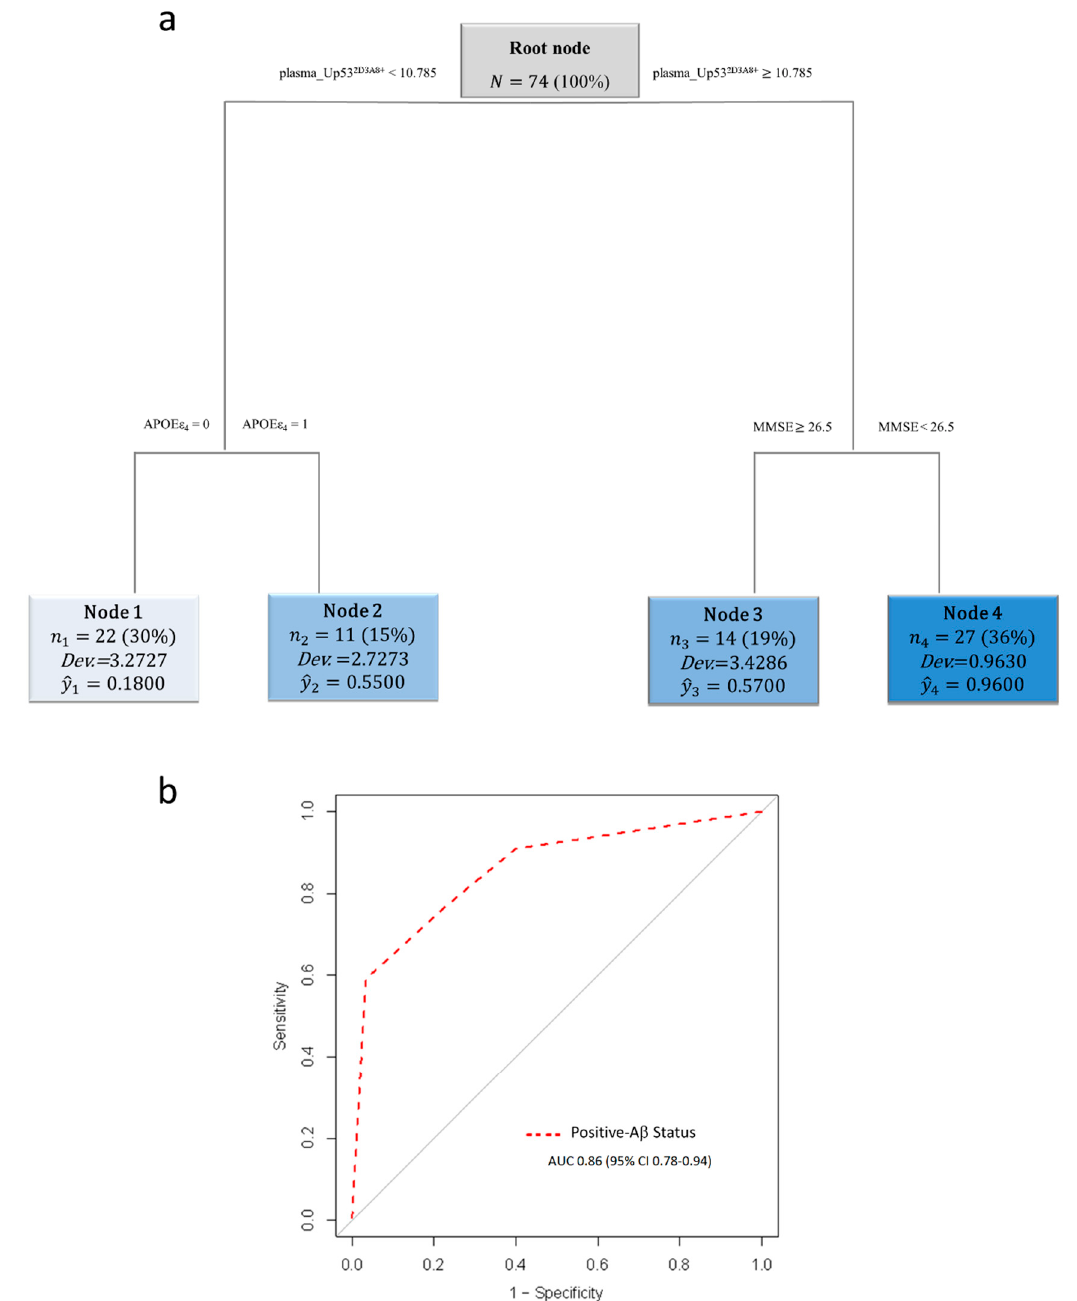
Figure 5. U-p53 2D3A8+ plasma-based algorithm classification of A β status in PharmaCog/E-ADNI subjects. Schematic representation of the regression tree algorithm obtained by combining U-p53 2D3A8+ with MMSE and APOE ε 4 to classify A − /T − ( n = 30) and A β + -subjects (A + /T +/ − ) ( n = 44) ( a ). ROC curve showed RT diagnostic performance in discriminating patients with A β + status. AUC = area under the curve ( b ). Cutoffs are expressed in arbitrary units (a.u.) and related only to the here-proposed in-house ELISA with a short-reference peptide used as internal